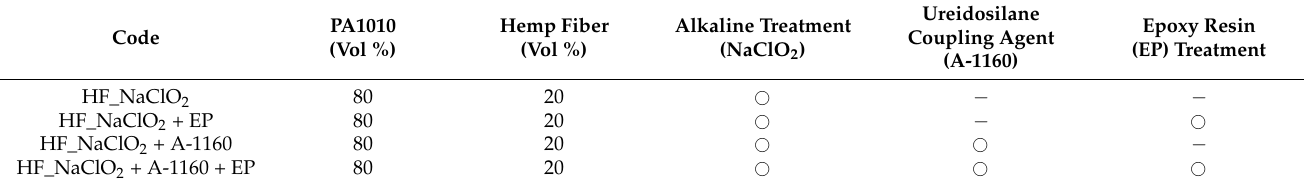
Table 2. Code, composition, and type of surface treatment of HF/PA1010 biomass composites used in this study.